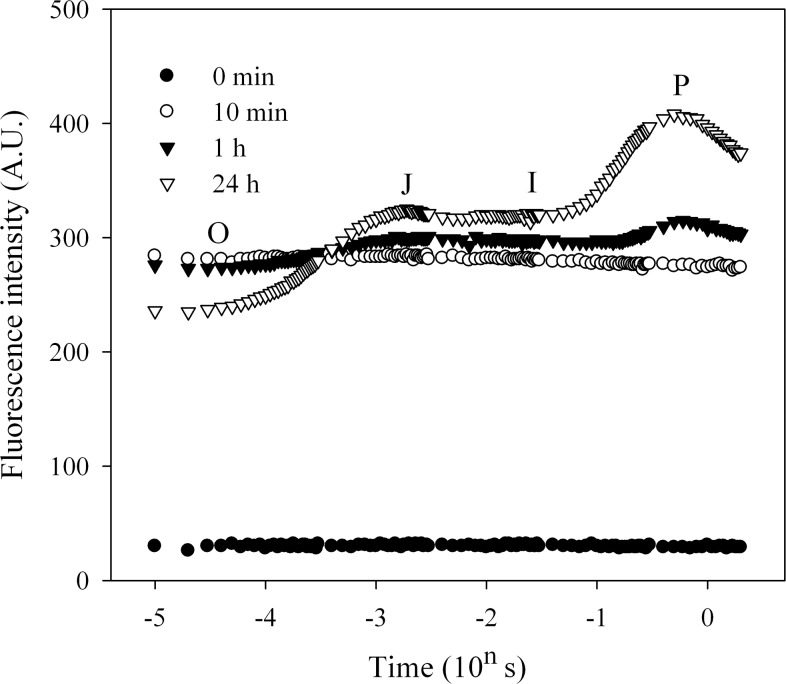
The recovery of chlorophyll fluorescence transients (O-J-I-P kinetic curves) in the rehydrated lichen soil crusts.Each kinetic curve just show the results of one sample from the three similar repetitions, and the other repetitive results are given in the Figure B in S1 File.